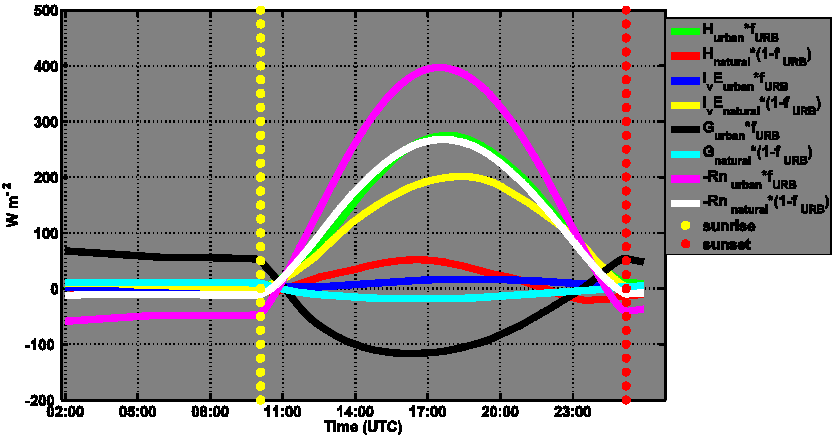
Fig. 9. Flux components of the average surface energy budget over the fourth model grid for case 10s. Fluxes are shown versus time (UTC) for the Period 02Z 24 June – 01Z 25 June 2007 in units ofWm − 2 for the components: urban surface sensible heat (green), natural surface sensible heat (red), urban surface latent heat (blue), natural surface latent heat (yellow), urban surface ground heat (black), natural surface ground heat (cyan), ( negative ) urban surface net radiation (pink) and ( negative ) natural surface net radiation (white). Approximate time of sunrise (sunset) is indicated by the yellow (red) dotted